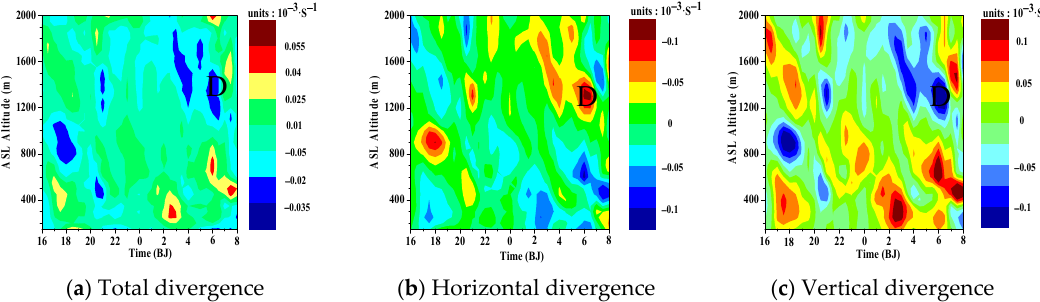
Figure 17. Time ‐ altitude diagram of the simulated divergence from the evening of 24 October to the morning of 25 October. ( a ) Total divergence ; ( b ) Horizontal divergence ;( c ) Vertical divergence.